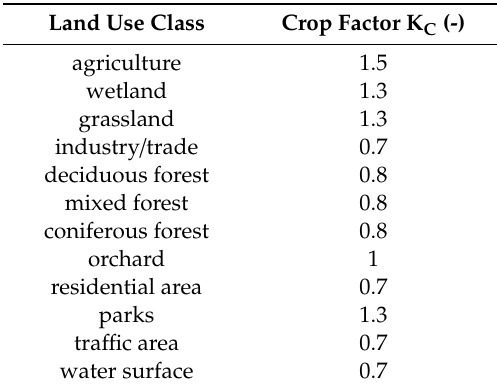
Table 5. Final vegetation coe ffi cients of the di ff erent land use